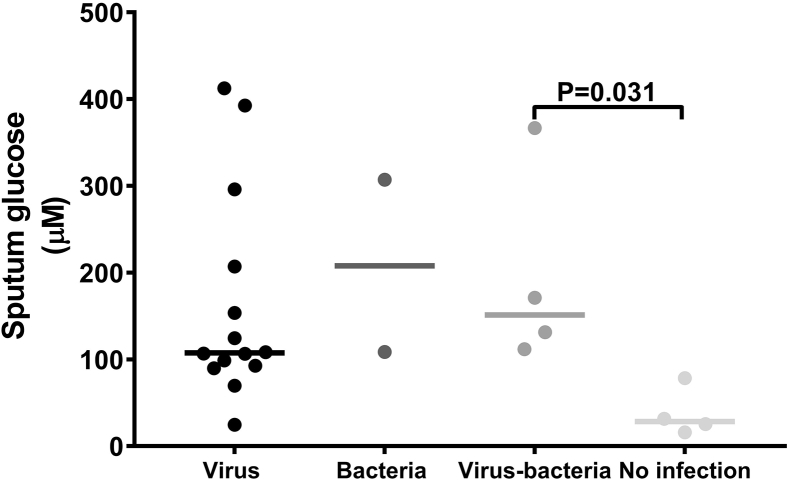
Sputum glucose concentrations in patients with naturally acquired exacerbations according to exacerbation cause.